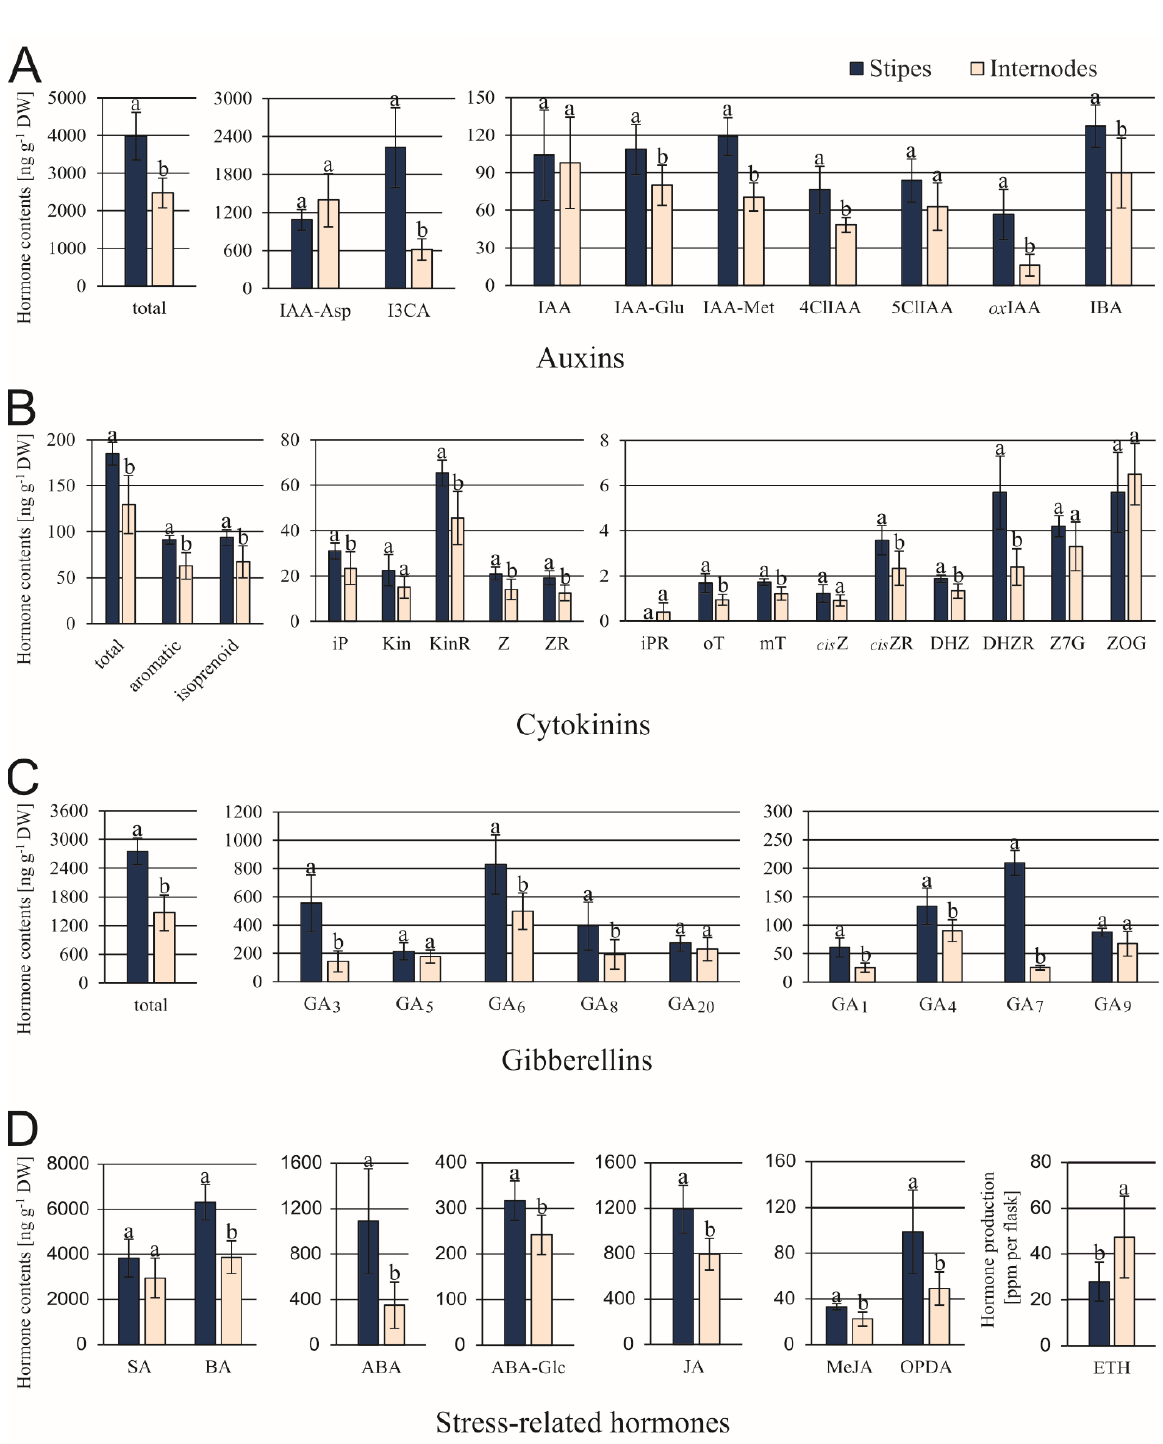
Figure 4. Contents of endogenous auxins ( A ), cytokinins ( B ), gibberellins ( C ), and stress-related hormones ( D ) in C. delgadii stipe and internode explants. Values represent the means ± standard deviation (SD) of 6 independent replicates. The Student’s t -test was used to estimate statistical significance of results for each type of compounds. Data followed by different letters (a, b) were significantly different at p < 0.05.